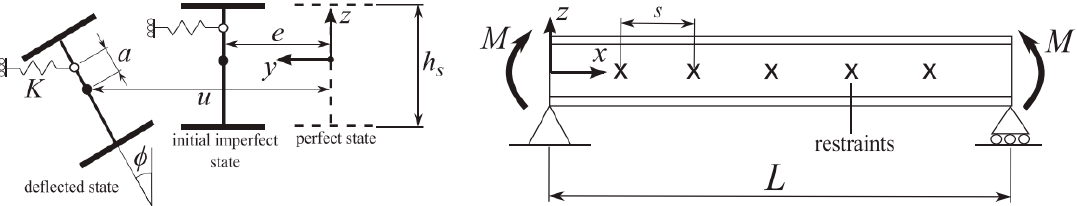
Figure 7. Reference analytical model for LR beams with discrete rigid lateral restraints. Figure